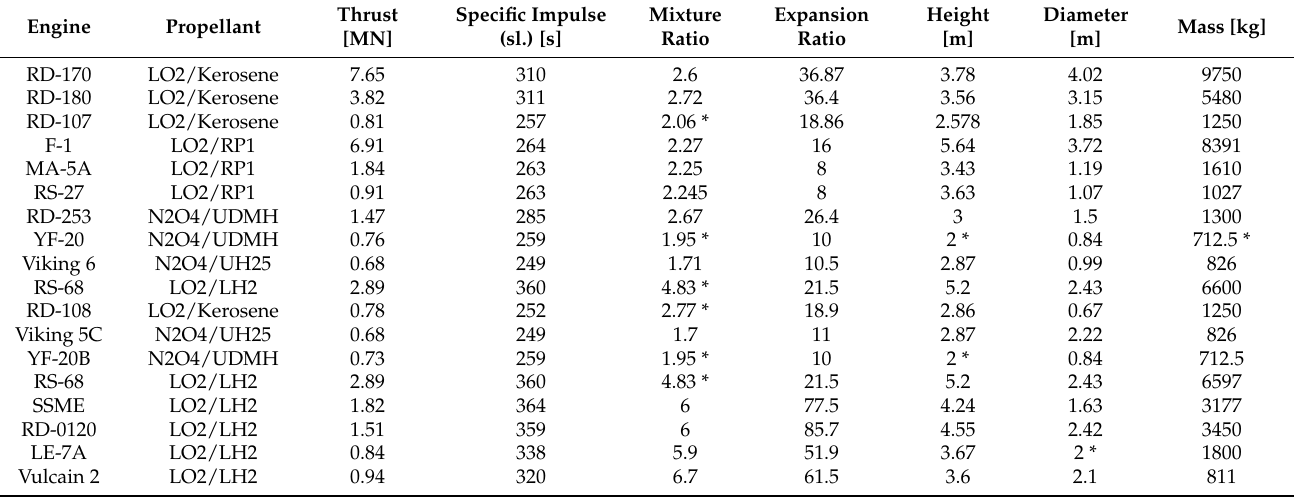
Table 3. Engines of the first stages [21–24]. The * symbol indicates an approximation due to lack of public